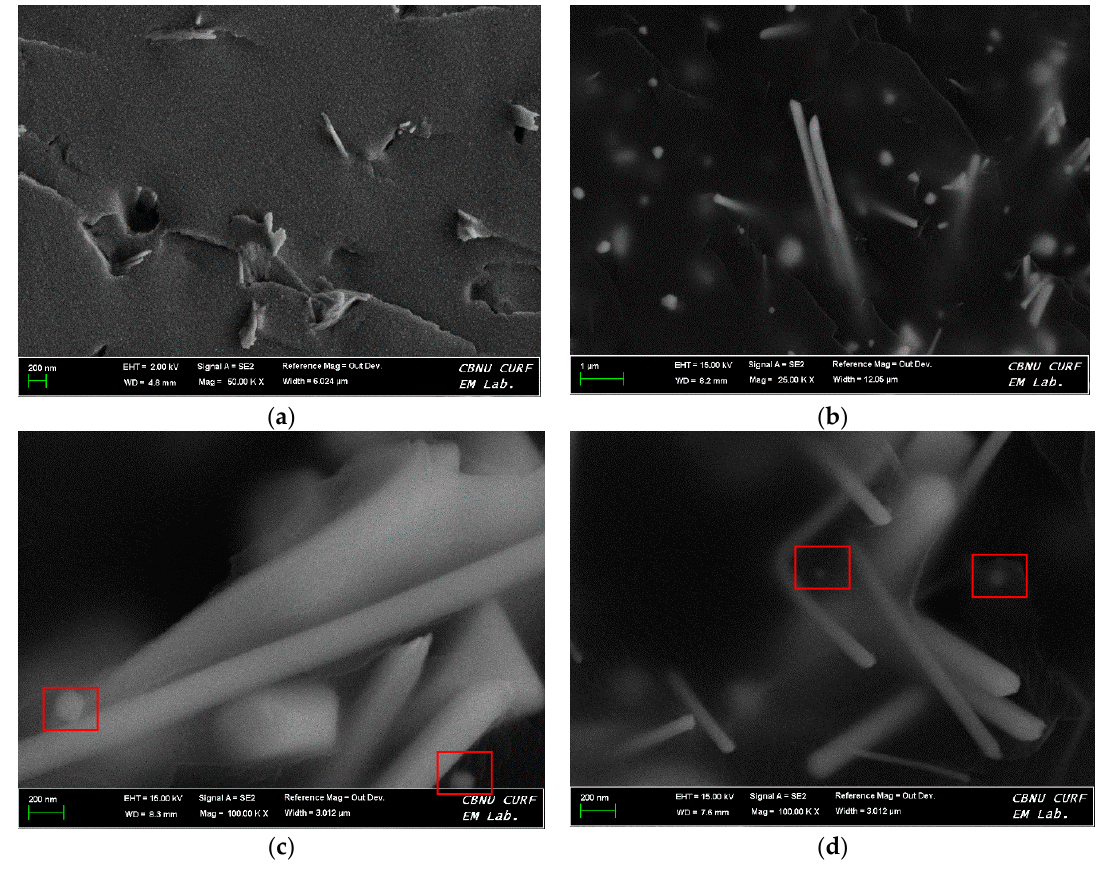
Figure 6. TEM images of the cured epoxy resin/silver nanocomposites: ( a ) sample cured with imidazole (scale bar, 200 nm); ( b ) sample cured with 10.0 wt % of the silver–imidazole complex with 6 vol % of AgNWs (scale bar, 1 µm); ( c ) magnified version of the sample in ( b ) (scale bar, 200 nm); ( d ) sample cured with 10.0 wt % of silver–imidazole with 8 vol % of AgNWs (scale bar, 200 nm).